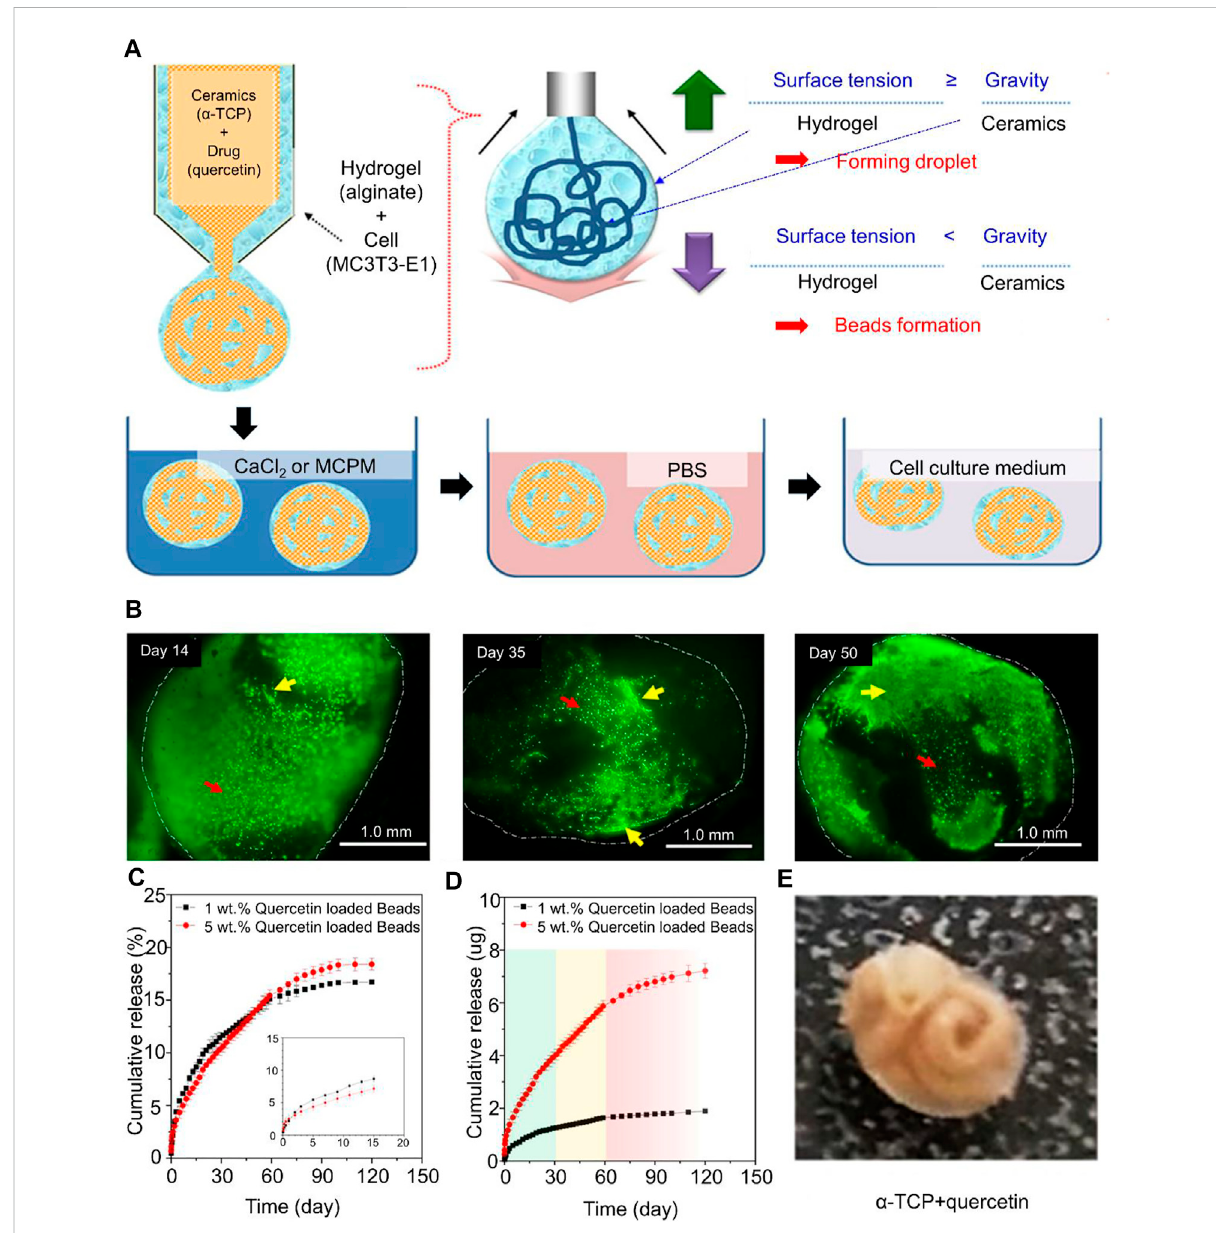
FIGURE 2 (A) Schematic of theprocessing of core − shellbeads. (B) Fluorescencemicroscopy images of live/dead cells incore − shellbeads (indicated with white dotted lines) cemented in PBS for 14, 35, and 50 days. Yellow arrows indicate cells showing growth and elongation, and red arrows